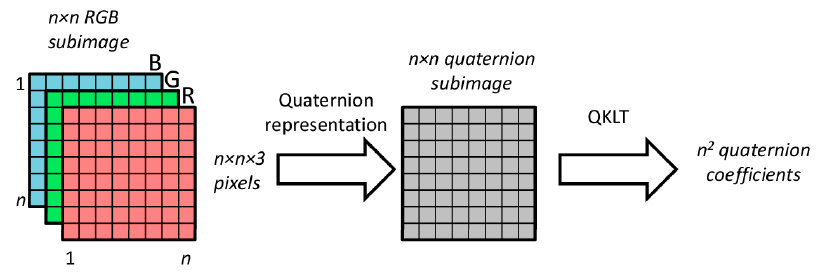
Figure 1. Quaternion representation of a sub-image and Quaternion Karhunen-Loève Transform (QKLT) coefficients derivation.